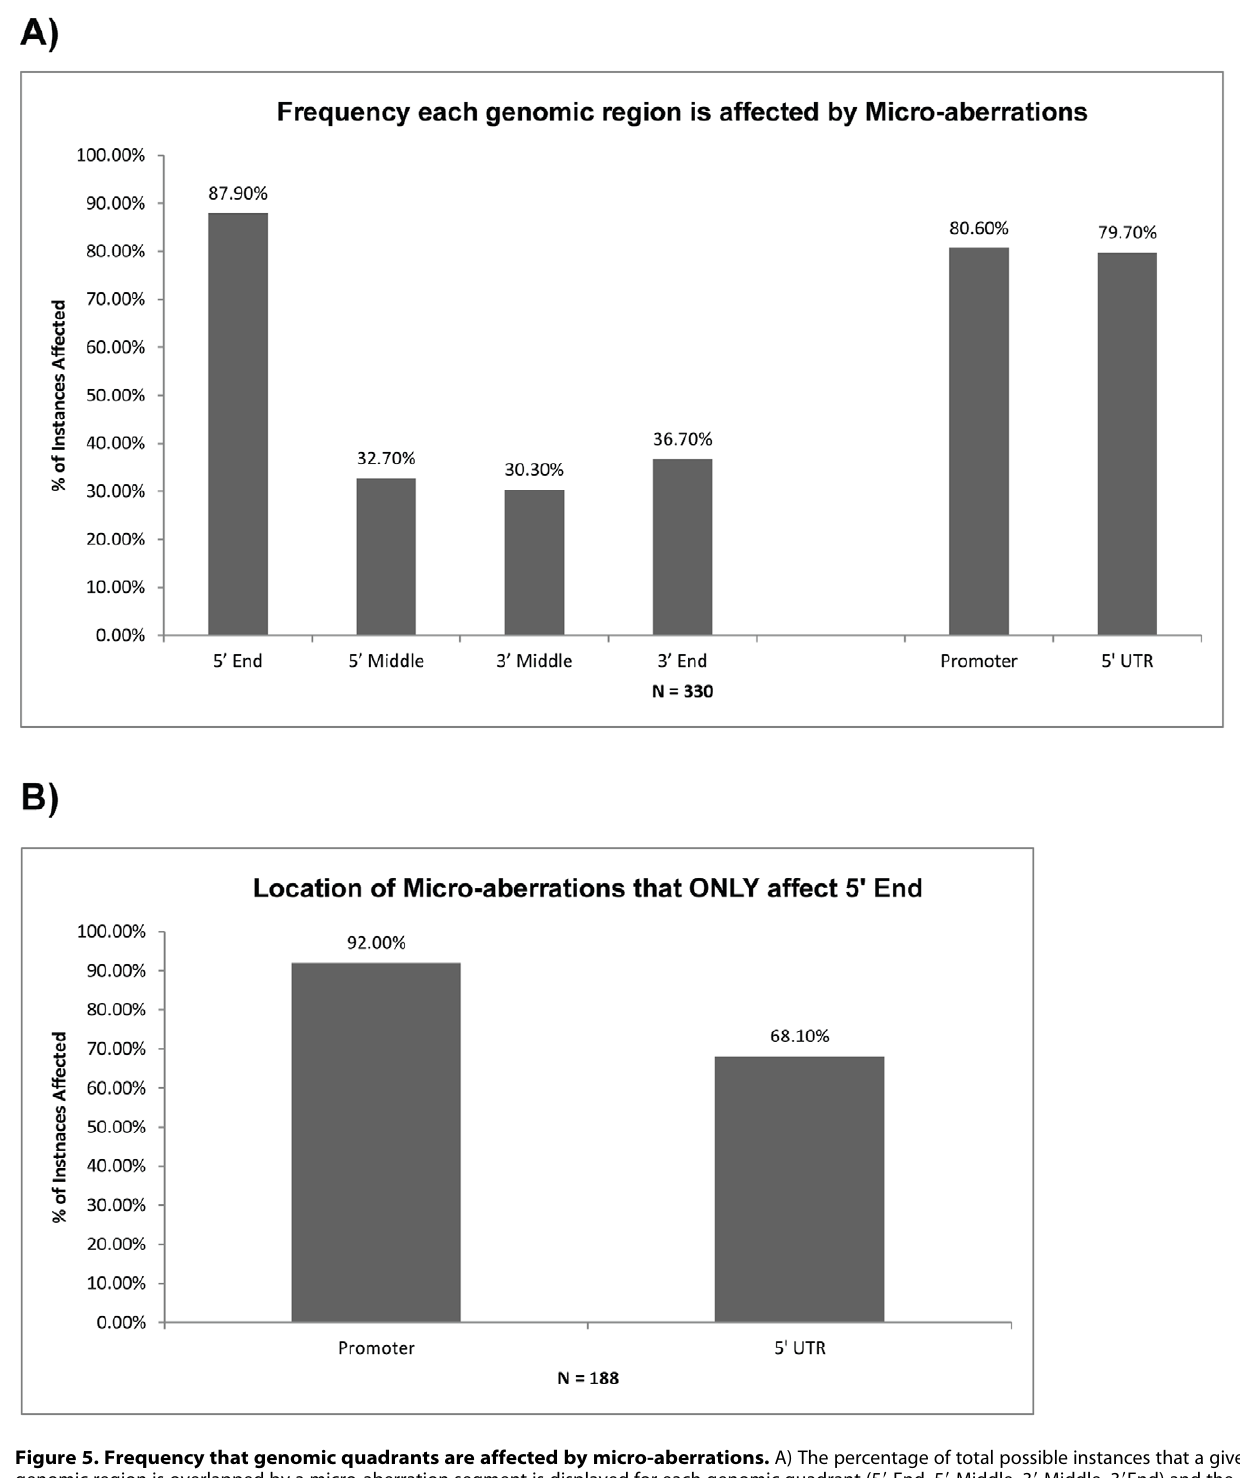
Figure 5. Frequency that genomic quadrants are affected by micro-aberrations. A) The percentage of total possible instances that a given genomic region is overlapped by a micro-aberration segment is displayed for each genomic quadrant (5 9 End, 5 9 Middle, 3 9 Middle, 3 9 End) and the 5 9 UTR and promoter regions. B) For the micro-aberrations that only affected the 5 9 End region, the % of instances where it affected the promoter or 5 9 UTR is listed. knock out the initial portion of the exon, resulting in the We also found that the 5 9 end of genes tended to be the most production of the observed aberrant mRNA (Figure S3 and S4). heavily affected by micro-aberration events, specifically the promoter region of the gene (Figure 5). It is unclear what leads